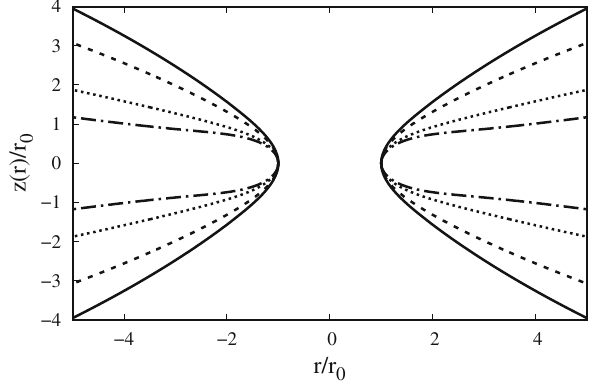
Fig. 4 b / r as a function of r / r 0 for c 0 = 0 . 96 (solid line), c 0 = 1 . 5 ρ (dashed line), normalized radial pres- Fig. 3 Normalized density r 2 0 (dashed line), c 0 = 3 (dotted line), c 0 = 4 . 5 (dash-dotted line) p r (dotted line), and normalized density plus radial pressure sure r 2 0 (ρ + pr ) (solid line) as a function of r / r = 1 r 2 0 . Fixed parameter c 0 0